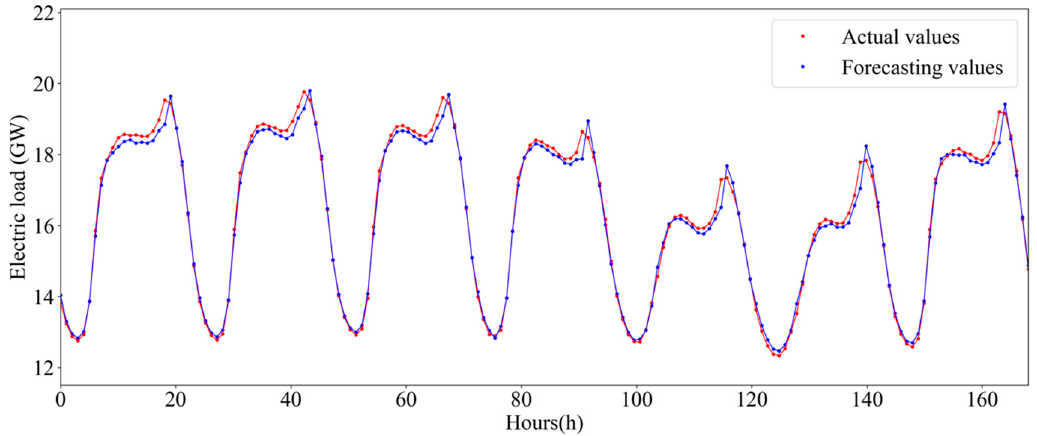
Figure 13. The comparison of real data and forecast data.